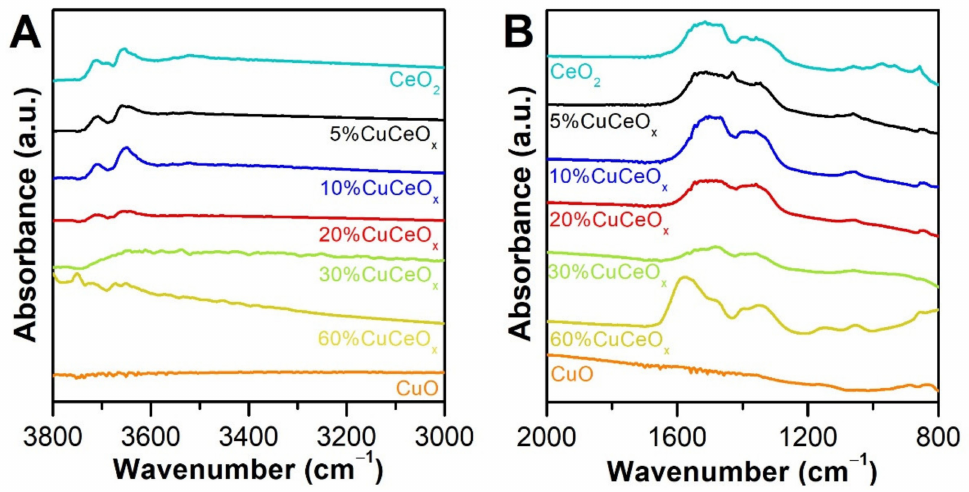
Figure 4. Normalized FT-IR spectra of the different catalysts outgassed at 150 ◦ C in the ( A ) 3800–3000 cm − 1 and ( B ) 2000–800 cm − 1